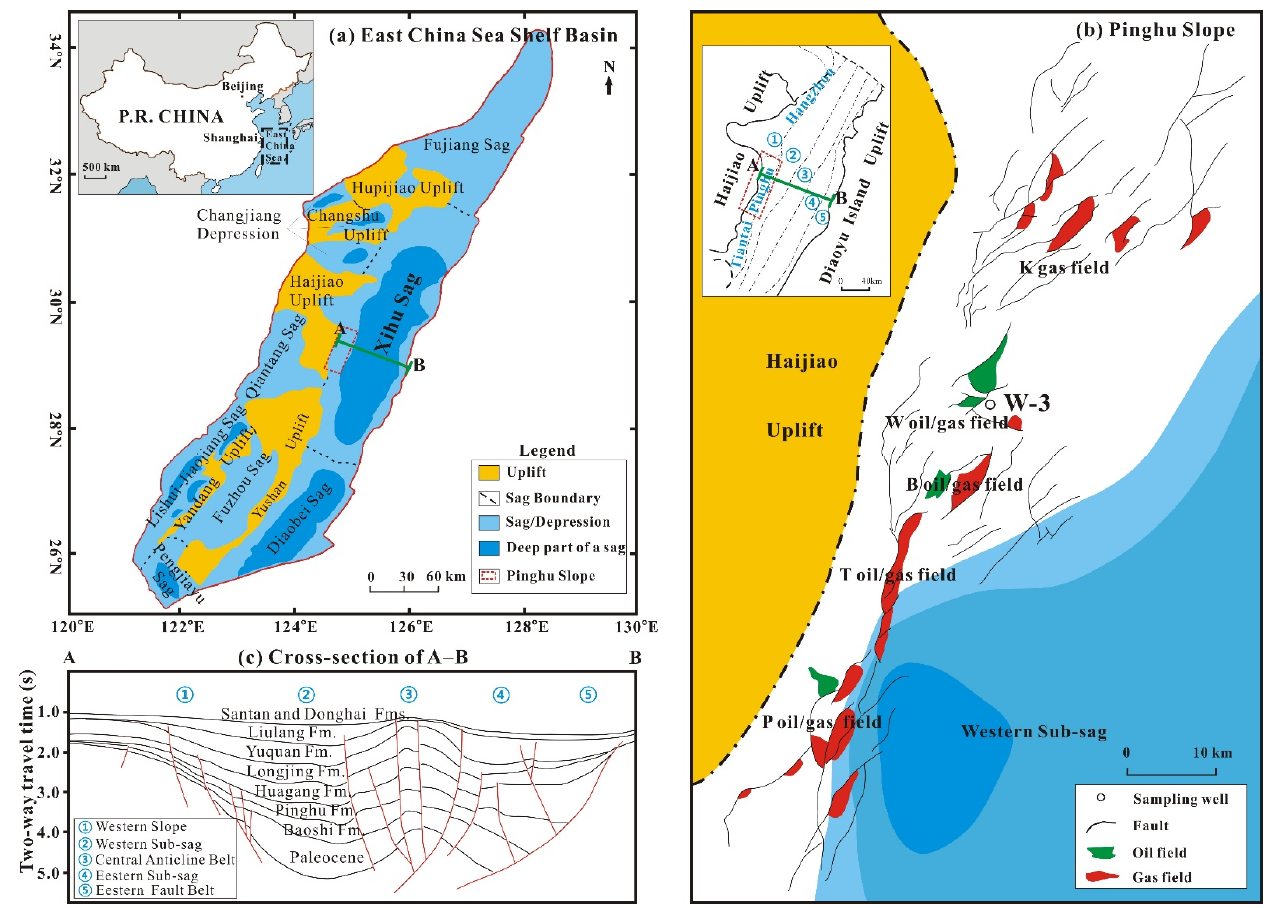
Figure 1. Map showing ( a ) tectonic sketch of the East China Sea Shelf Basin (ECSSB), ( b ) Pinghu Slope of the Xihu Sag, ECSSB, and ( c ) structural cross-section of the Xihu Sag (A–B, shown in Figure 1a,b). (adapted from [17]).